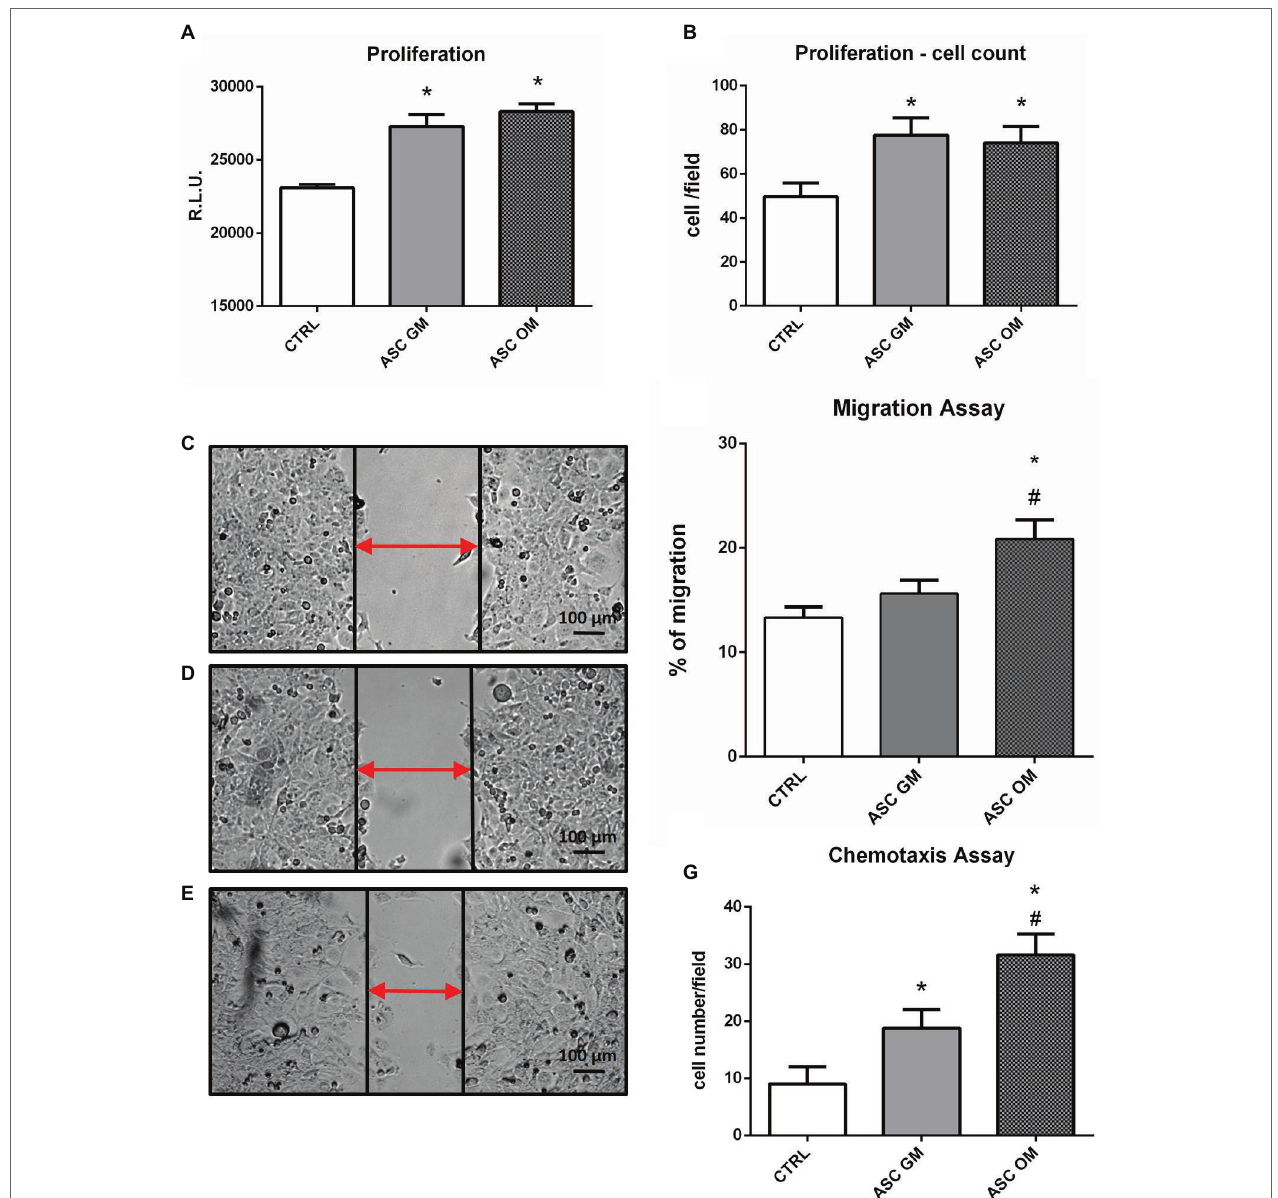
FIGURE 2 | Biological effects induced by ASCs on co-cultured endothelial cells. (A) ATP-based proliferation assay performed on HMECs upon 24 h of co-culture with ASCs. (B) Cell count (DAPI staining) proliferation assay. (C–F) Migration assay performed on HMECs alone (CTRL) or upon co-culture with ASCs maintained in growth medium (GM) or osteodifferentiating medium (OM). (C–E) Representative picture of wound healing assay. (F) Quantification of endothelial cells migration in the indicated co-culture conditions. Data represent migration rate of HMEC after 8 h. (G) Chemotaxis assay performed on HMECs. The symbol (*) indicates statistical significance of ASC OM or ASC GM compared to the control condition (without ASCs) considering a p <0.05. The symbol (#) indicates statistical significance of ASC OM compared to ASC GM considering a p <0.05. CTRL, HMEC without ASCs; ASC GM, HMEC in co-culture with undifferentiated ASC; ASC OM, HMEC in co-culture with osteodifferentiating